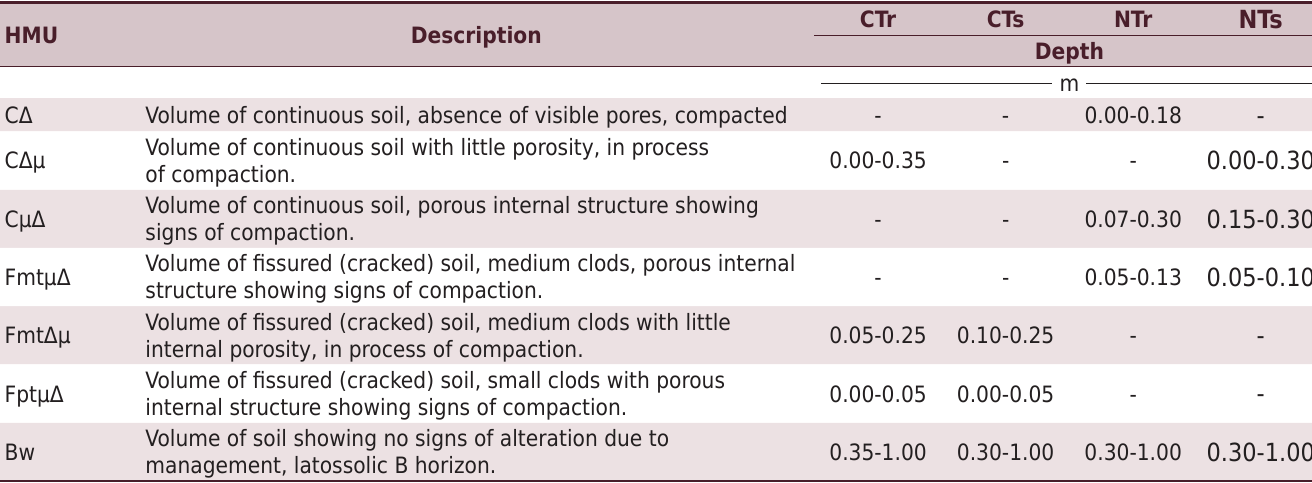
Table 1. Description of the homogeneous morphological units (HMU) and the depth of occurrence of the HMU in a Ferralsol under conventional tillage (CT) and no-tillage (NT), and crop management consisting of rotation (r) and succession (s)